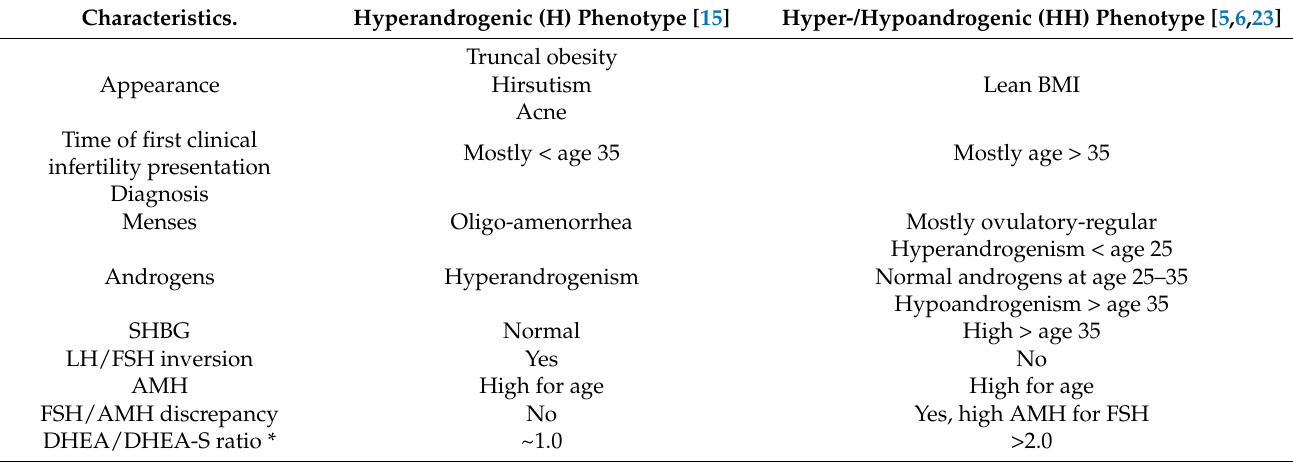
Table 1. Differential diagnosis between H-PCOS and HH-PCOS phenotypes.